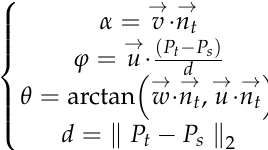
7 of 15 Figure 7. Complete point cloud diagram of casting.